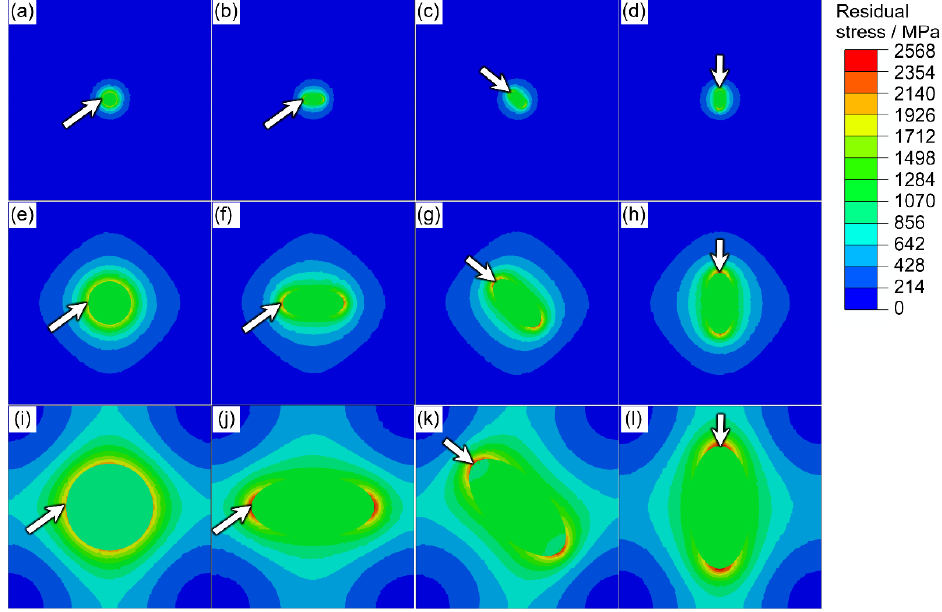
Figure 4. The residual stress distribution around different inclusions in one typical RVE (the white arrows point at the positions for maximum residual stresses): ( a – d ) √𝑎𝑟𝑒𝑎 = 26.6 μm; ( e – h ) √𝑎𝑟𝑒𝑎 = 13.3 μm; ( i – l ) √𝑎𝑟𝑒𝑎 = 4.2 μm .